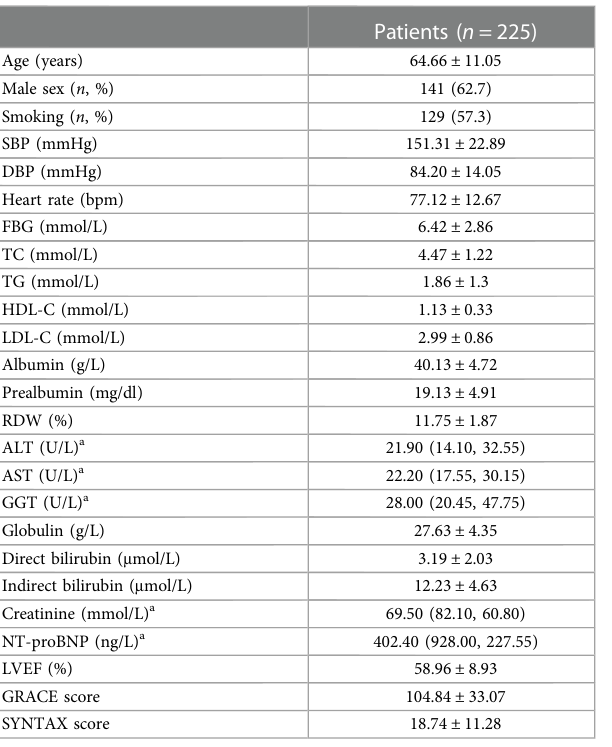
TABLE 1 Characteristics of patients.